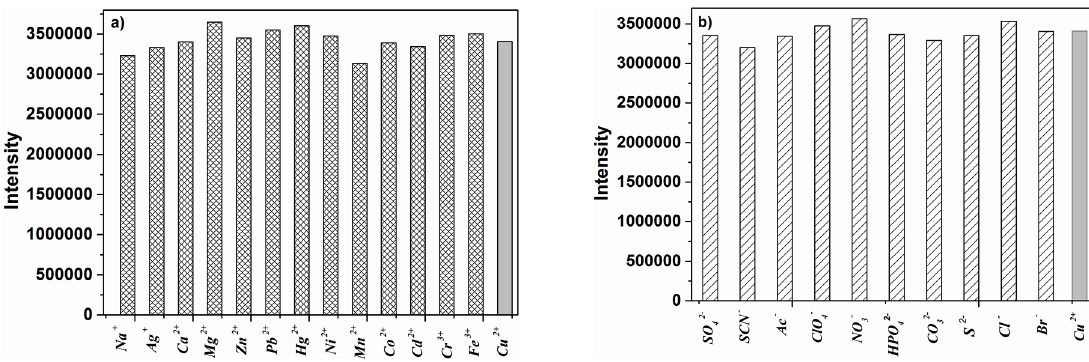
Figure 3. ( a ) Fluorescence response of P (2 μ M) to 10 μ M of Cu 2+ or to the mixture of 50 μ M individual metal ions with 10 μ M of Cu 2+ in ethanol-water solution (3:2, v:v, 50 mM HEPES, pH 7.4); ( b ) Fluorescence response of P (2 μ M) to 10 μ M of Cu 2+ or to the mixture of 50 μ M individual anions with 10 μ M of Cu 2+ .